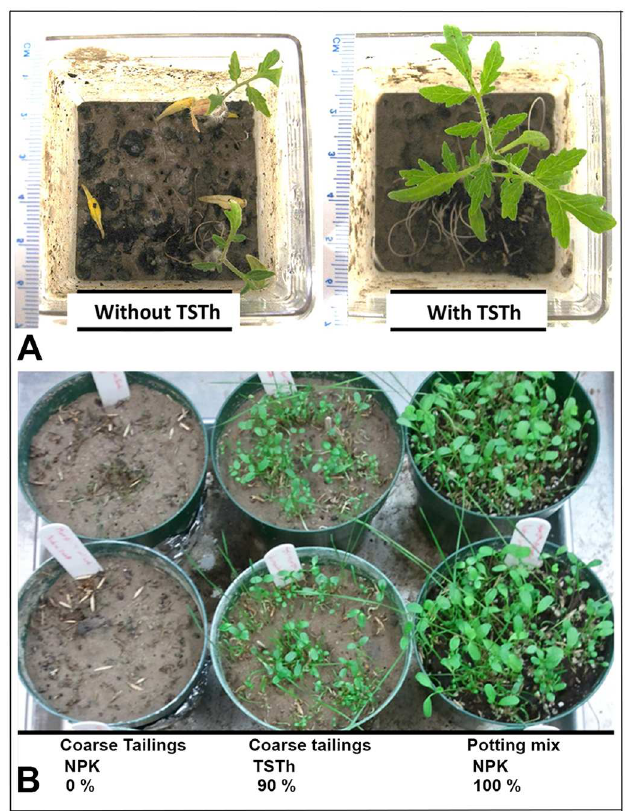
Fig 2. Plant growth is improved with Trichoderma harzianum TSTh20-1. A) Two week old control (left) or TSTh-inoculated (right) tomato seedlingswere transplanted to coarse tailings(CT), then given ultrapurewater for an additional 2 weeks. B) Equal numbers of white clover and slender wheat grass seeds were scattered on CT (left, middle) or potting mix (right). Left- and right-handpots were treated with NPK. TSTh-treated seeds on CT (middle)were given ultrapurewater. Pots were photographed at 3